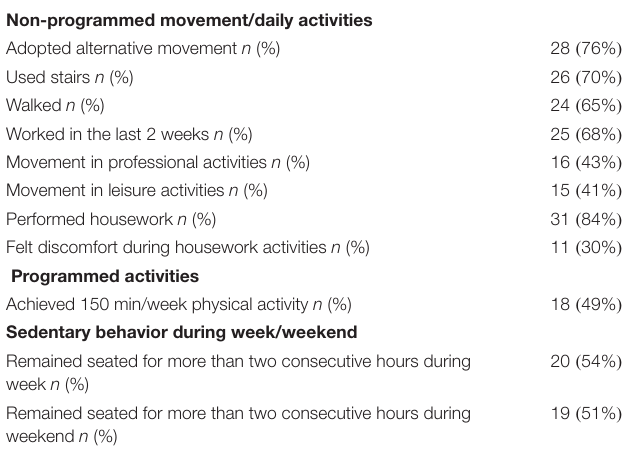
TABLE 2 | Evaluation of programmed and non-programmed physical activities of breast cancer survivors enrolled in a program for physical activity, who answered a survey on their level of activity, ( n = 37).